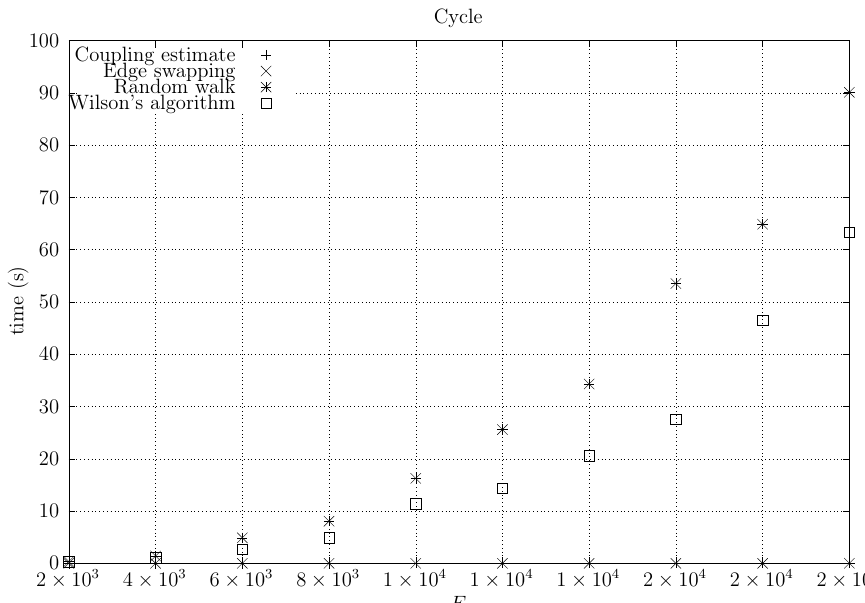
Figure 28. Running times for cycle graphs averaged over five runs, including the running time for computing the optimistic coupling estimate, the running time for generating a spanning tree based on that estimate, the edge-swapping algorithm, the running time for generating a spanning tree through a random walk, and the running time for Wilson’s algorithm.